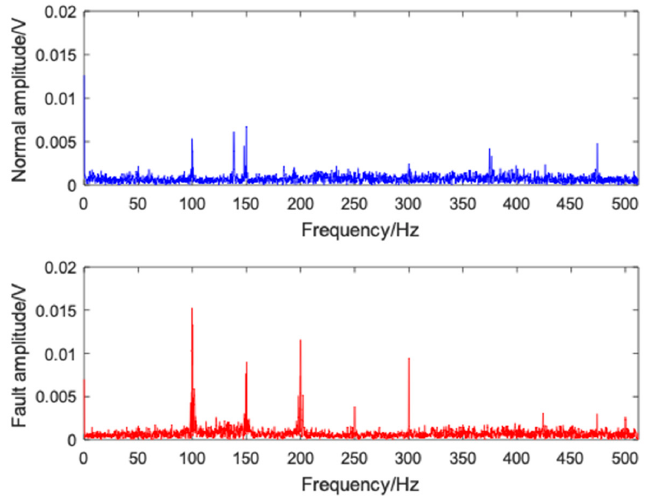
Figure 5. Spectrum diagrams of the collected vibration signals.